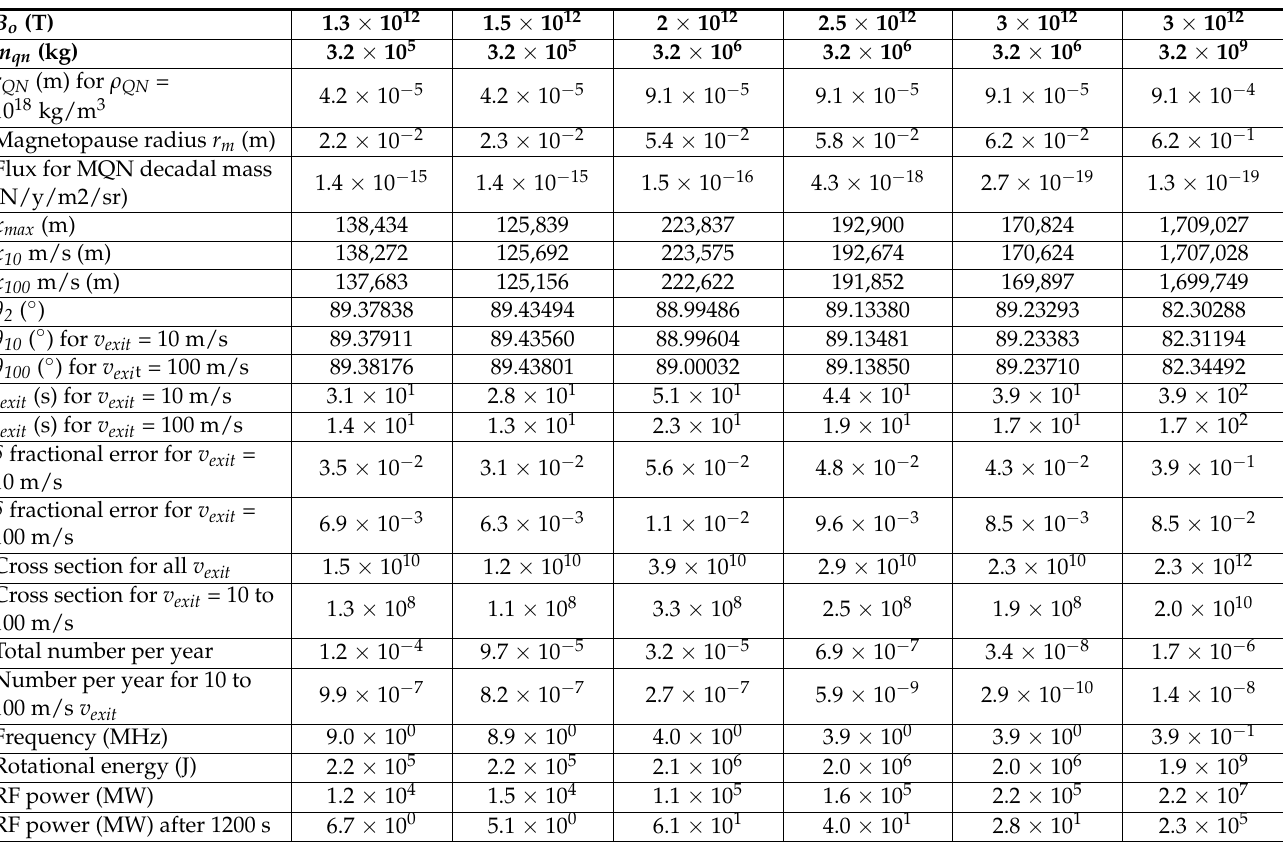
Table A2. Representative examples are given for MQNs with impact velocity of 250 km/s transiting through granite as a function of B o and MQN mass m qn